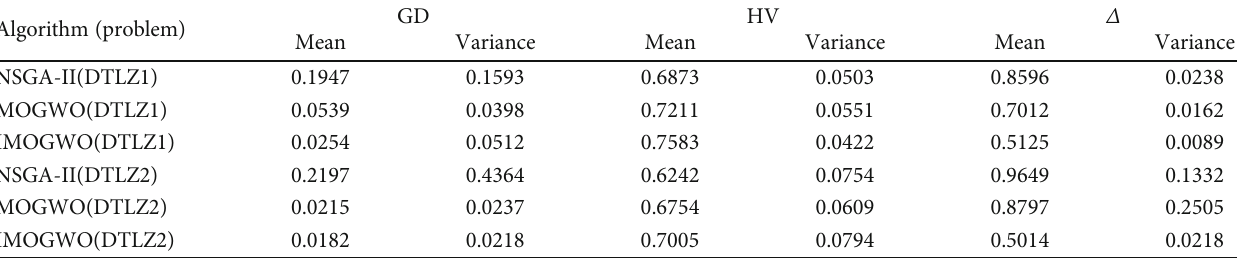
Figure 7: Paretofront obtained by solving DTLZ2 with 3 algorithms: (a) NSGA-II, (b) MOGWO, and (c) IMOGWO. Table 1: Comparison of performance indicators of 3